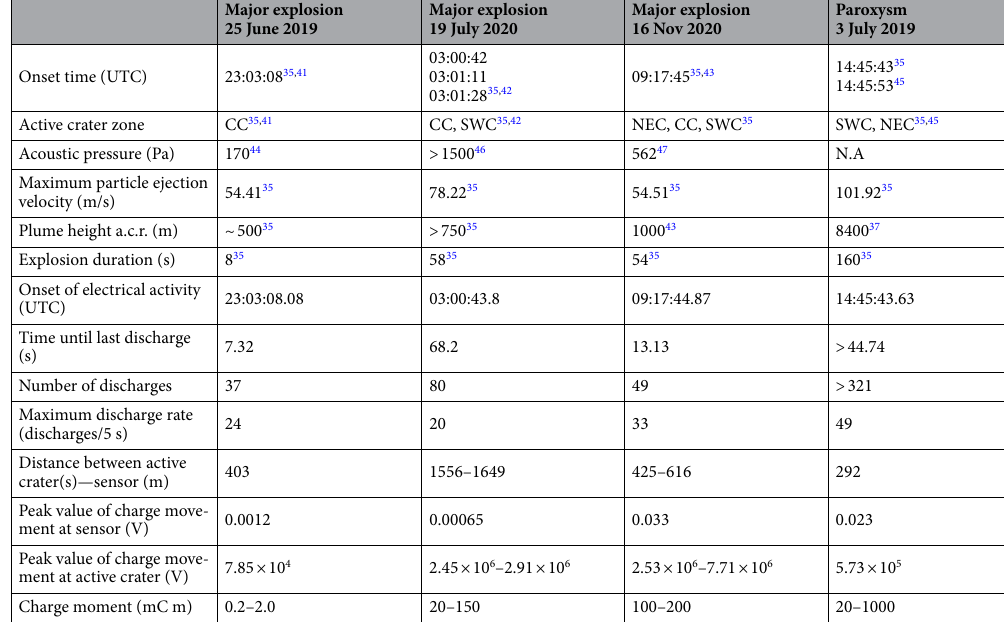
Table 1. Eruption parameters and electrical measurements for the 25 June 2019, 19 July 2020 and 16 November 2020 major explosions and the 3 July 2019 paroxysm.